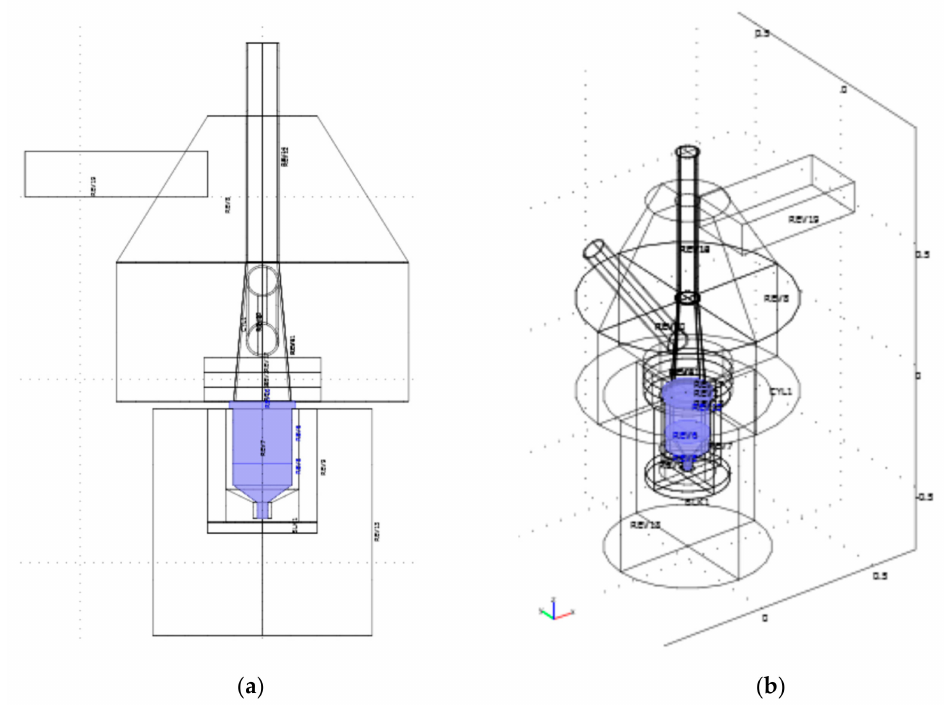
Figure 3. Model geometry, with highlighted the load (crucible) position: ( a ) longitudinal cross section; ( b ) 3D view.